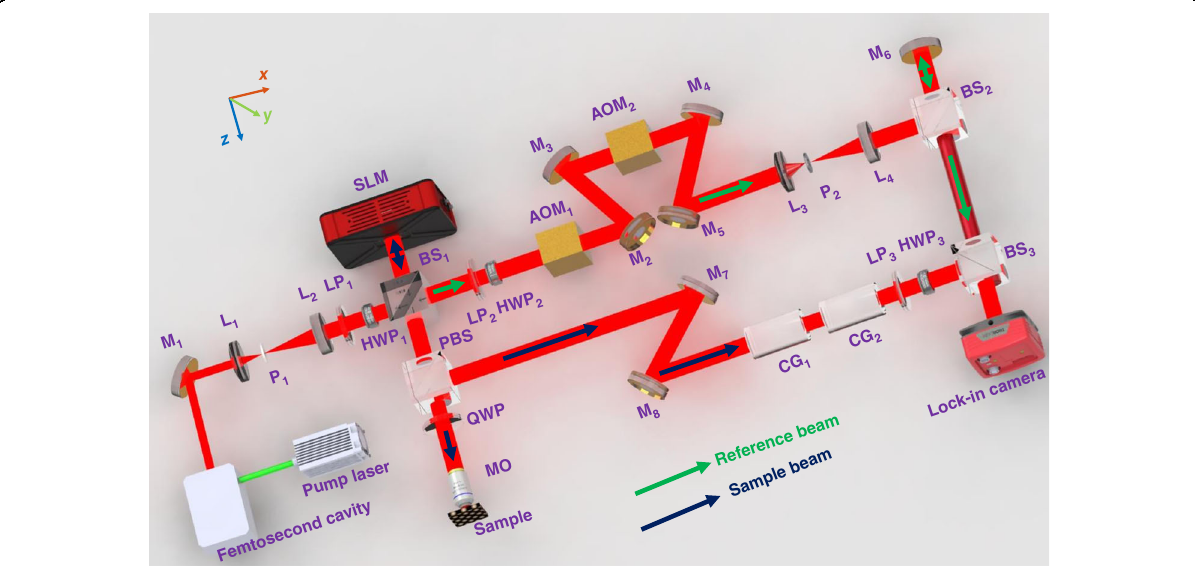
Fig. 2 Experimental setup for the wide- fi eld re fl ection matrix optical coherence tomography to enhance the delivery of light energy deep in the sample. The weak interference signal from mixing the reference arm (green arrow) and sample arm (purple arrow) is fi rst improved using optical heterodyne detection and then recorded by the lock-in camera. M mirror, L lens, P pinhole, LP linear polarizer, HWP half-wave plate, BS beam splitter, PBS polarization beam splitter, AOM acousto-optic modulator, MO microscopy objective, SLM spatial light modulator, CG compensation